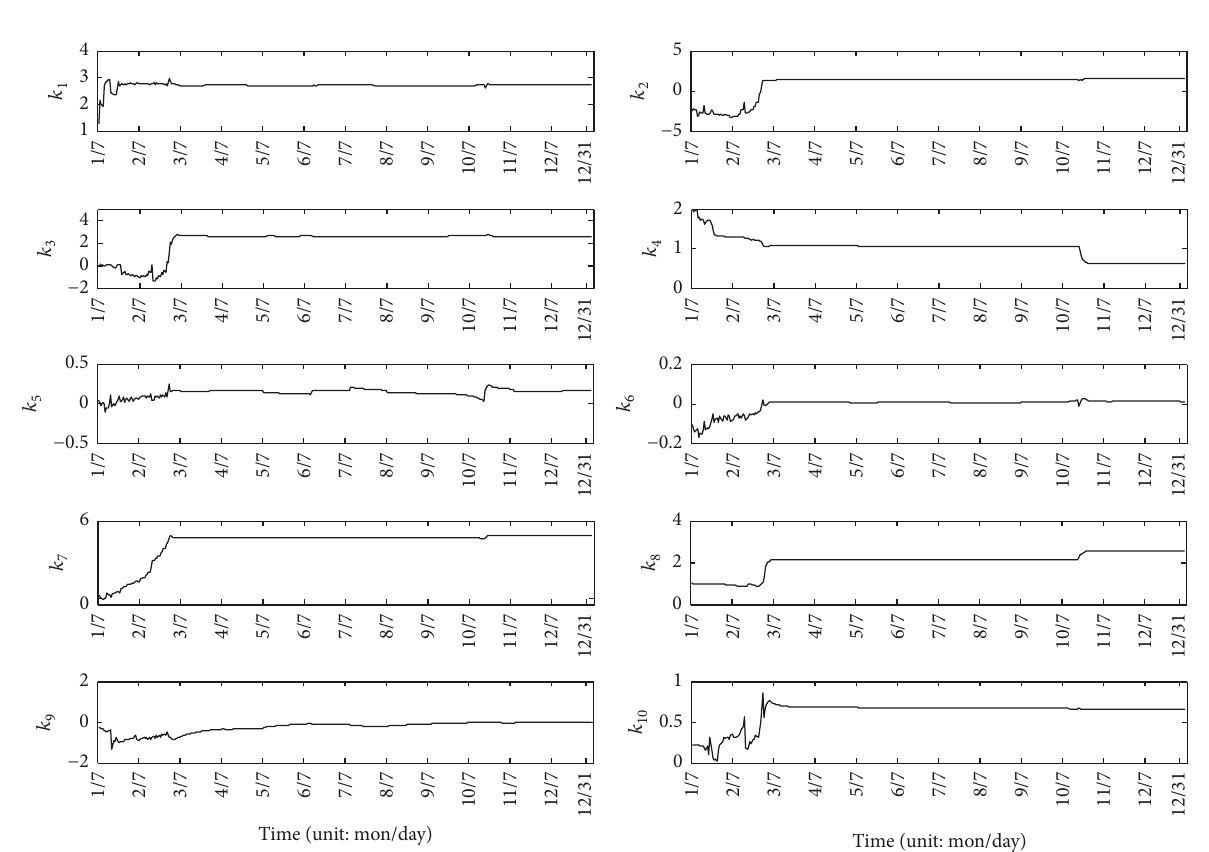
Figure 6: Real-time estimated values of ten unknown model